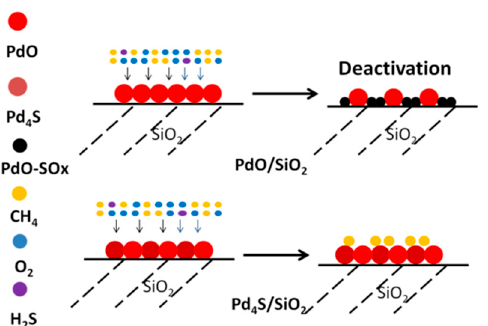
Figure 12. Hydrogen sulfide temperature-programmed desorption (H 2 S-TPD)profiles of the u7 catalyst and freshly prepared PdO/SiO 2